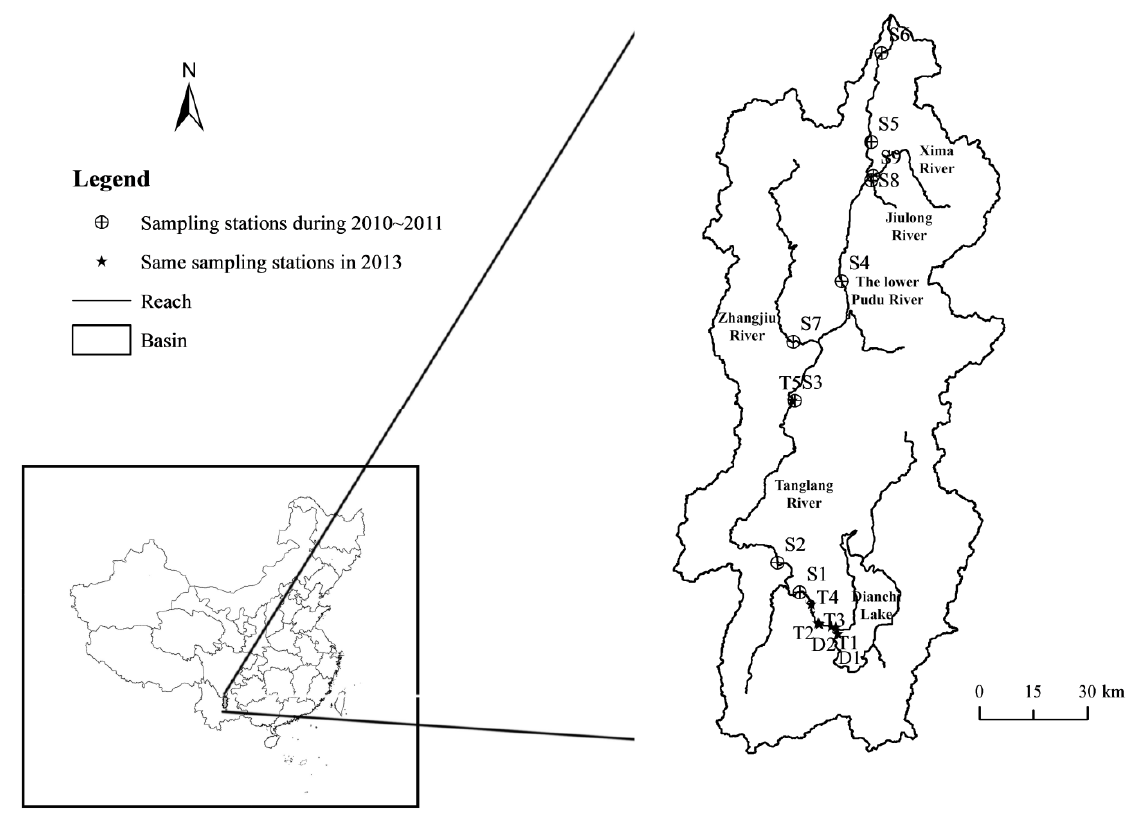
Figure 1. Map of study area and sampling stations in the two